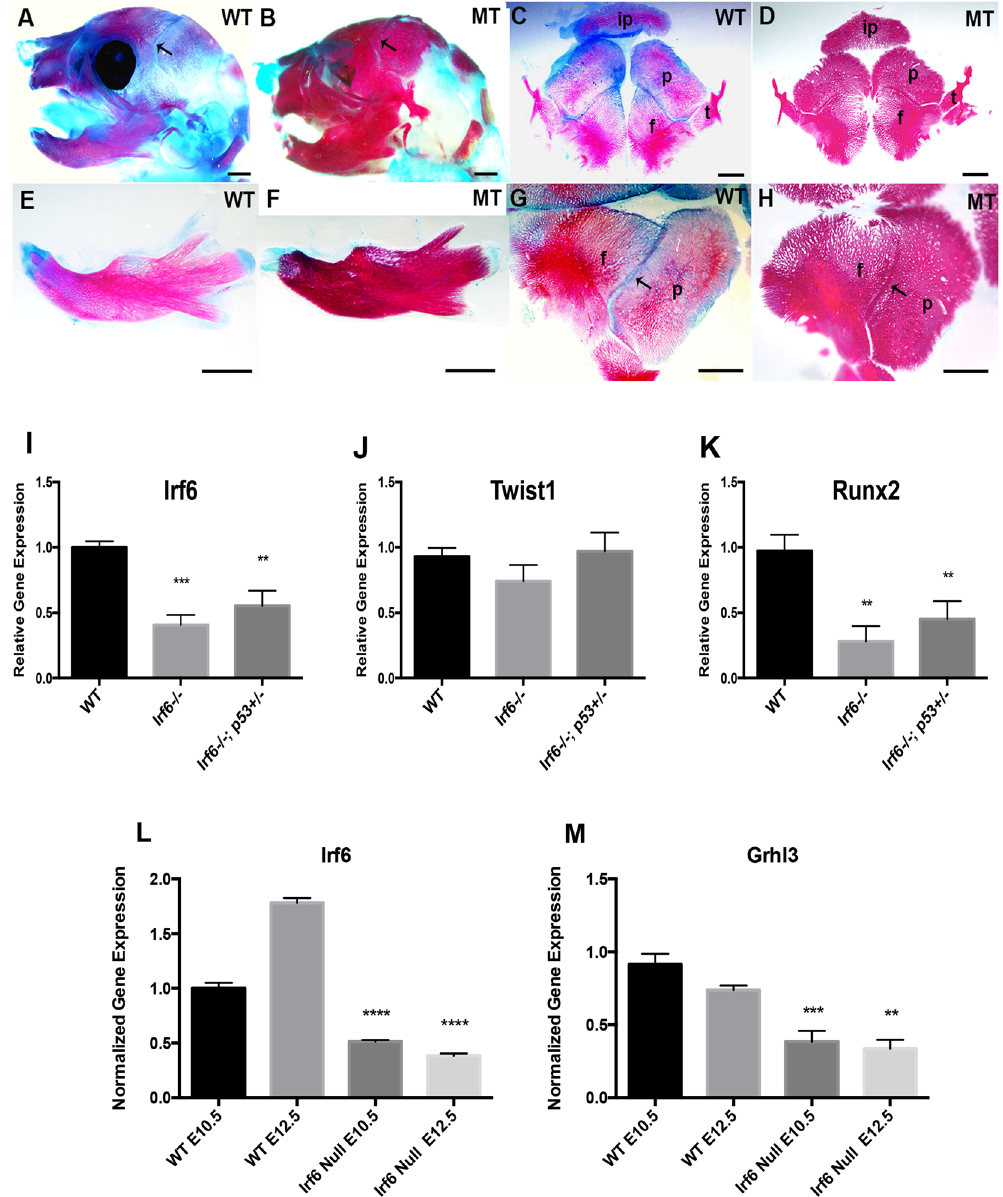
Figure 4. Craniofacial skeletal abnormalities in Irf6 null pups and quantitative expression of selected genes. ( A – H ) Bone (red) and cartilage (blue) of head and mandible of P0 pups. Relative to wild type littermates ( A , C , E , G ), mutant pups ( B , D , F , H ) have less cartilage ( B , F ), and the mandible is missing a distal bone where the incisor is normally formed ( E versus F ). The mandibular processes are shorter ( F ). The coronal sutures of the skull of Irf6 null pups are fused (arrows) ( D , H ) compared to wild type littermate ( C , G ). Scale bars: 1000 μ m. Expression of Irf6 , Tw1 and Runx2 is reduced in Irf6 null embryos at E14.5 compared to wild type littermate ( I – K ). Similarly, the expression of Irf6 and Runx2 genes is reduced to a lesser extent in compound alleles for Irf6 null and p53 heterozygous embryos at E14.5, except for Tw1 where the expression is slightly increased ( J ). The relative gene expression is the average of two independent experiments with four technical replicates for each genotype. The asterisks represent the level of statistical significance of the average of gene expression compared to wild type embryos. The data are the average of two independent experiments. Similarly, the expression of Irf6 and Grhl3 is significantly reduced in Irf6 null embryos at both E10.5 and E12.5 ( L , M